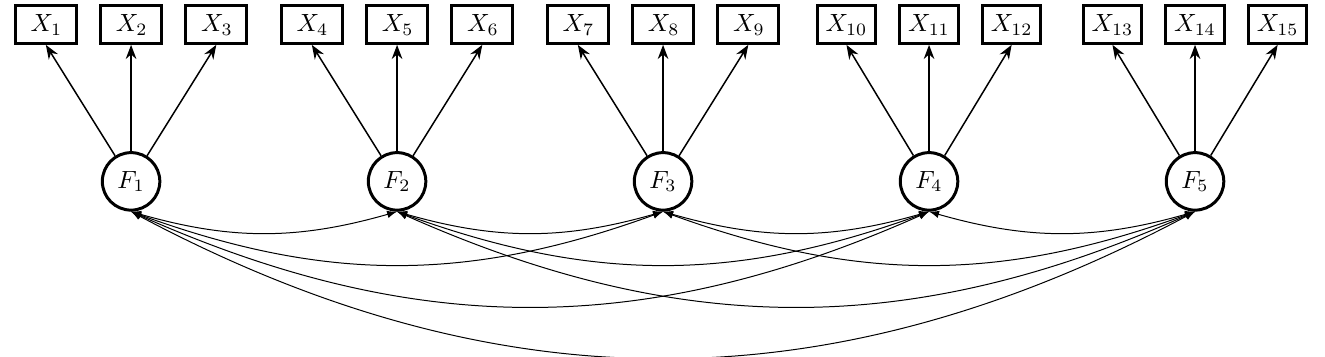
Figure 6. Simulation Study 4: Data-generating model without cross loadings or residual correlations (DGM1).